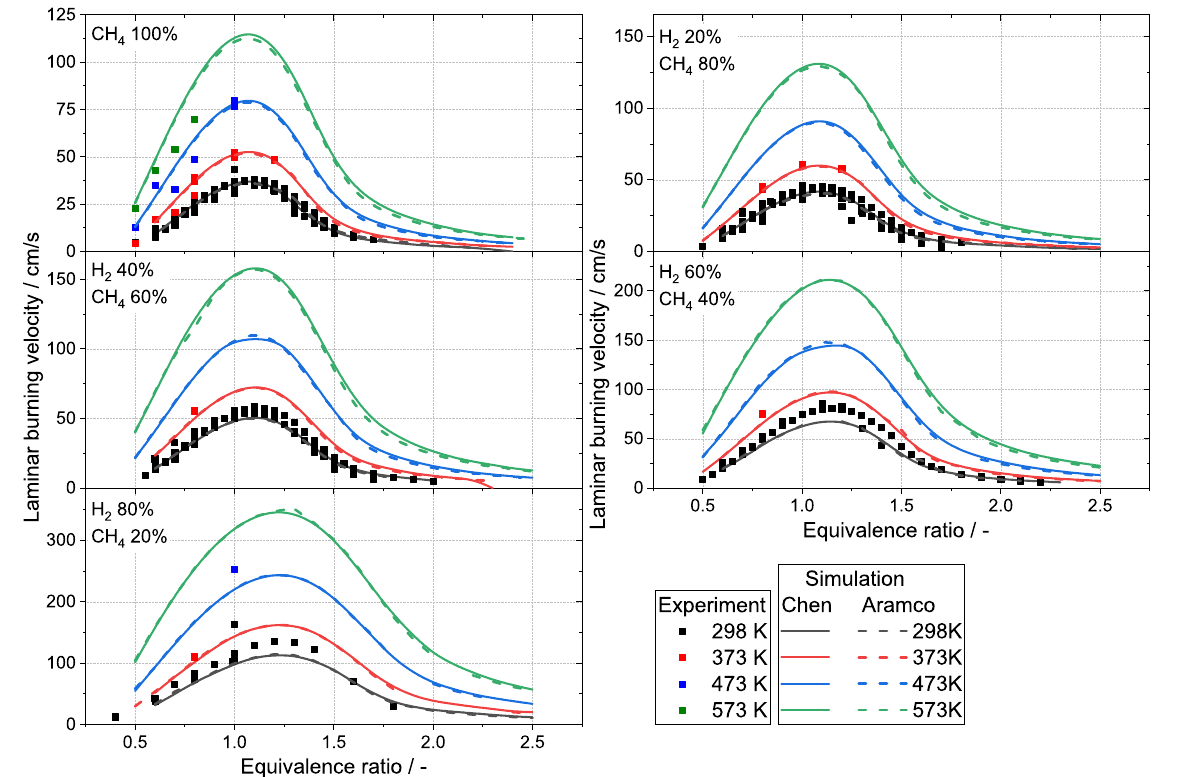
Figure 6. Comparison of the laminar burning velocity of a methane–hydrogen mixture ( p = 1bar) for different temperatures (298, 373, 473and 573K) to the experimental literature data from Table